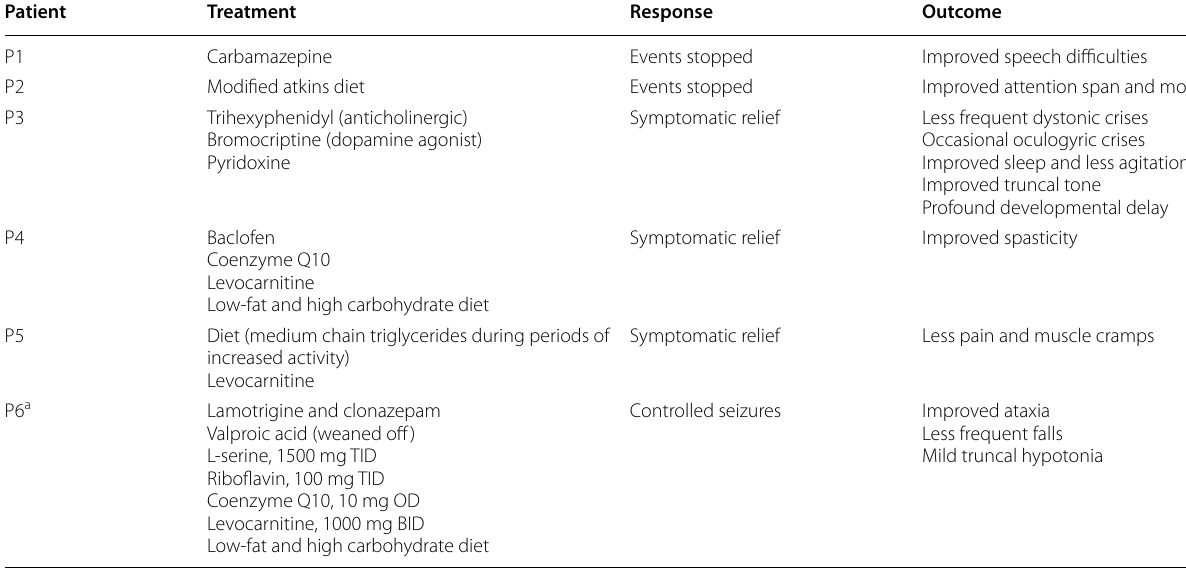
a Published in Ali A. et al. Genes[10]